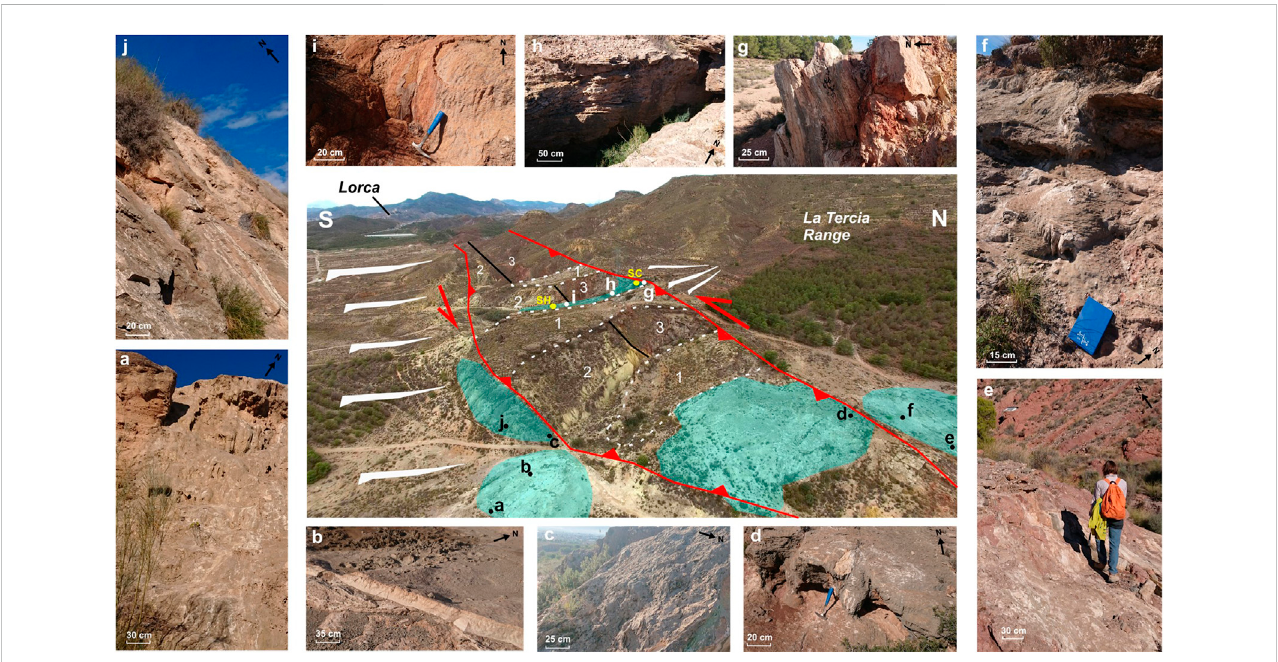
FIGURE 3 The central photo correspondsto an interpretativediagram oftheCarraclaca aerial view. The red linesare thefaults that limit thetectonicblock liftedby twobranchesoftheAlhamadeMurciafaultatthebaseofLaTerciarange.Theblacklinesindicateanon-activefaultaffectingMiocenedeposits.Bluecoloured areas show travertine deposits. The numbers in the central image refer to the different materials present in the area. (1) Glacis crust. (2) Yellow marls. (3) Red conglomerates and Blue marls. The yellow dots show the position of the water source samples. The letters (A – J) indicate sampling sites. (A) Samples